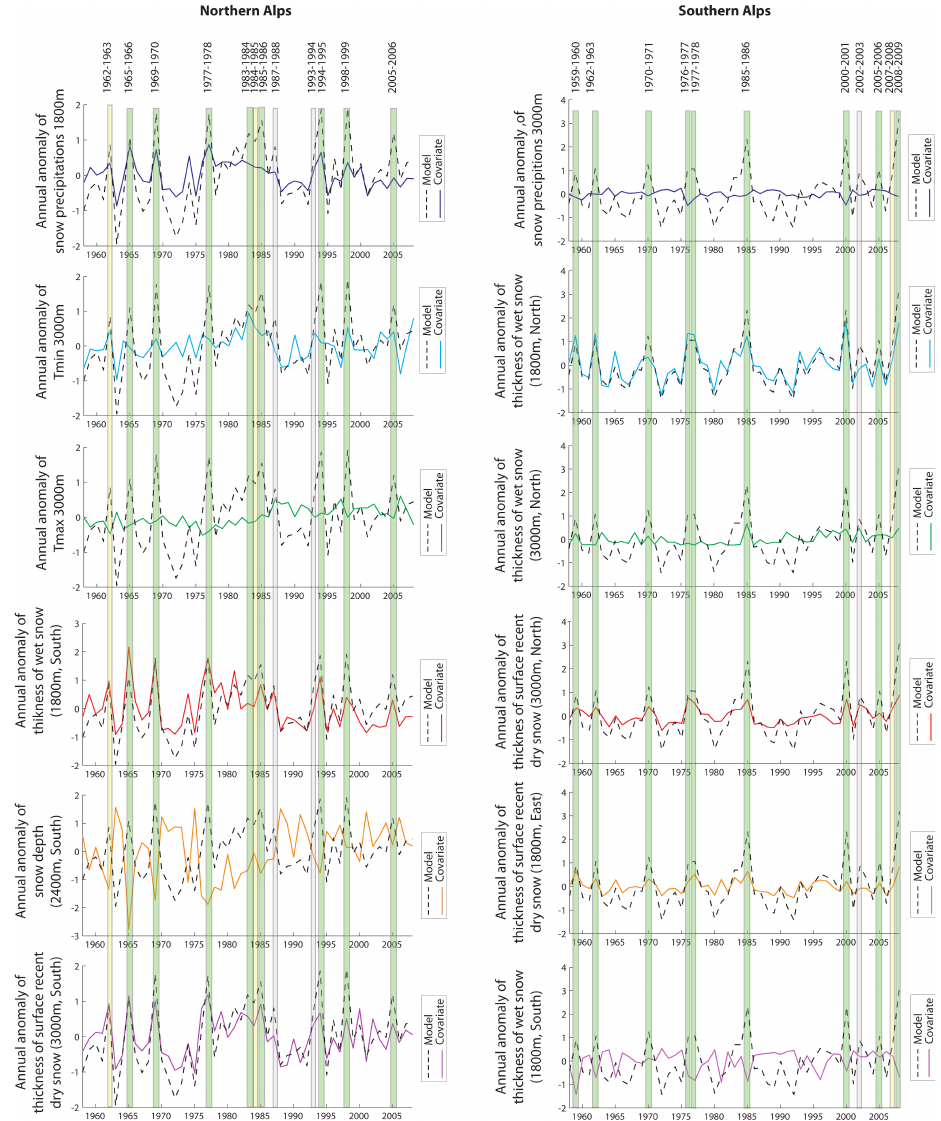
Fig. 7. Temporal evolution of the covariates retained in the regression model of the composite index, for the Northern and Southern French Alps. Green bands correspond to years for which the CI and its regression model exceed the 80th percentile threshold (see Table 2). Yellow and grey bands correspond to years for which only the model or the CI exceeds the threshold,